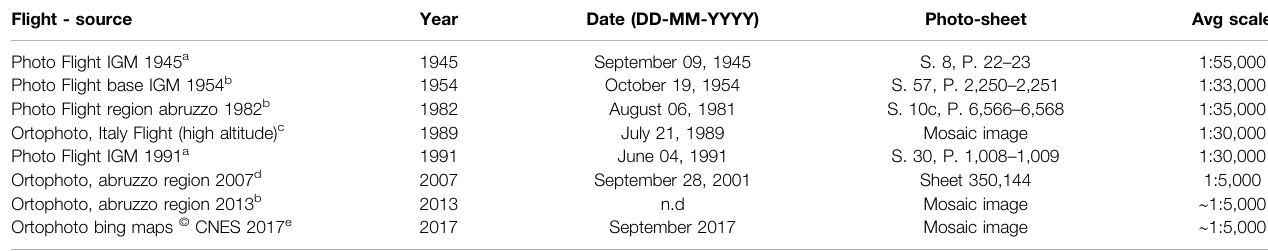
TABLE 3 | Aerial photo and orthophotos used for the